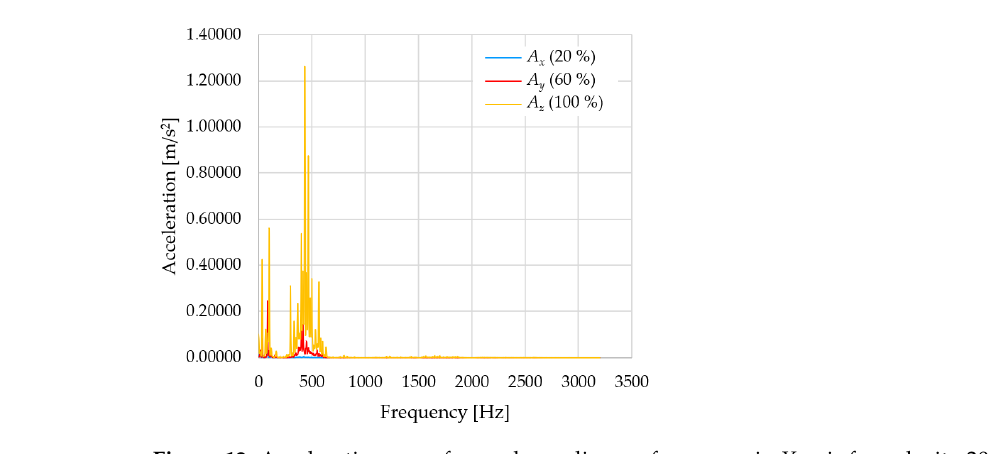
Figure 12. Acceleration waveforms depending on frequency in X -axis for velocity 20, 60 and 100%.